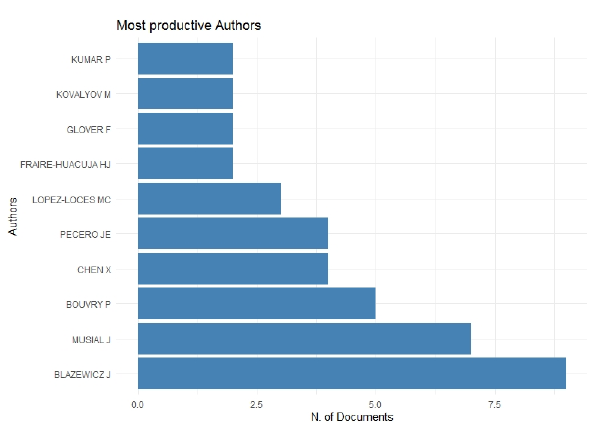
Fig. 4. The Most Produtive Authors about ISOP Topic